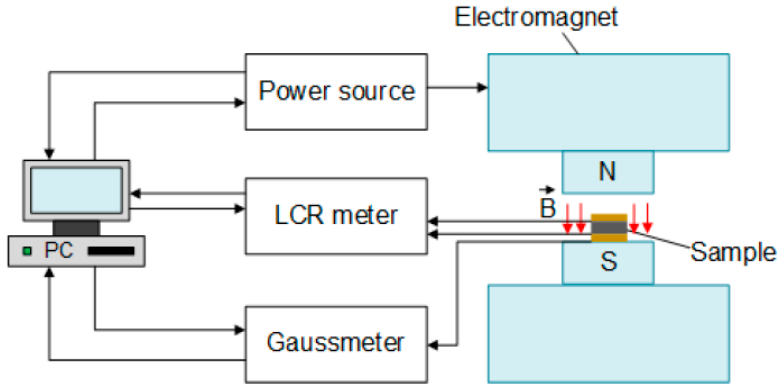
Figure 7. Schematic diagram of the experimental setup. Red arrows designate the applied magnetic field. Black arrows show symbolically the signal flow.